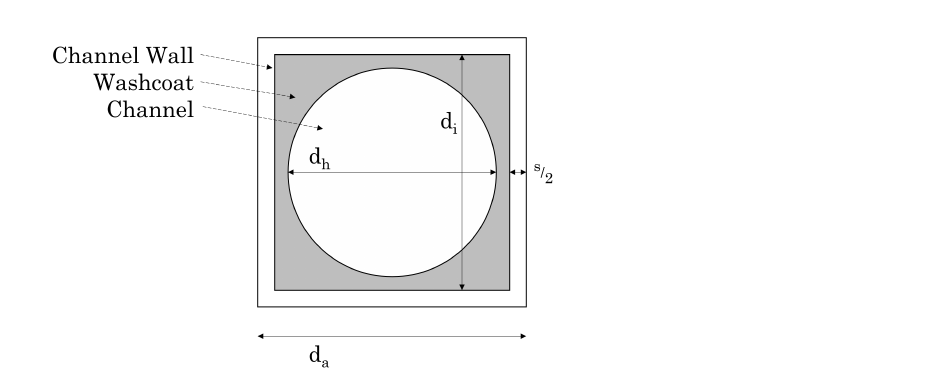
Figure 8. A single channel is the selective catalytic reduction (SCR) device with the outer channel diameter, inner channel diameter, circular diameter, and wall thickness